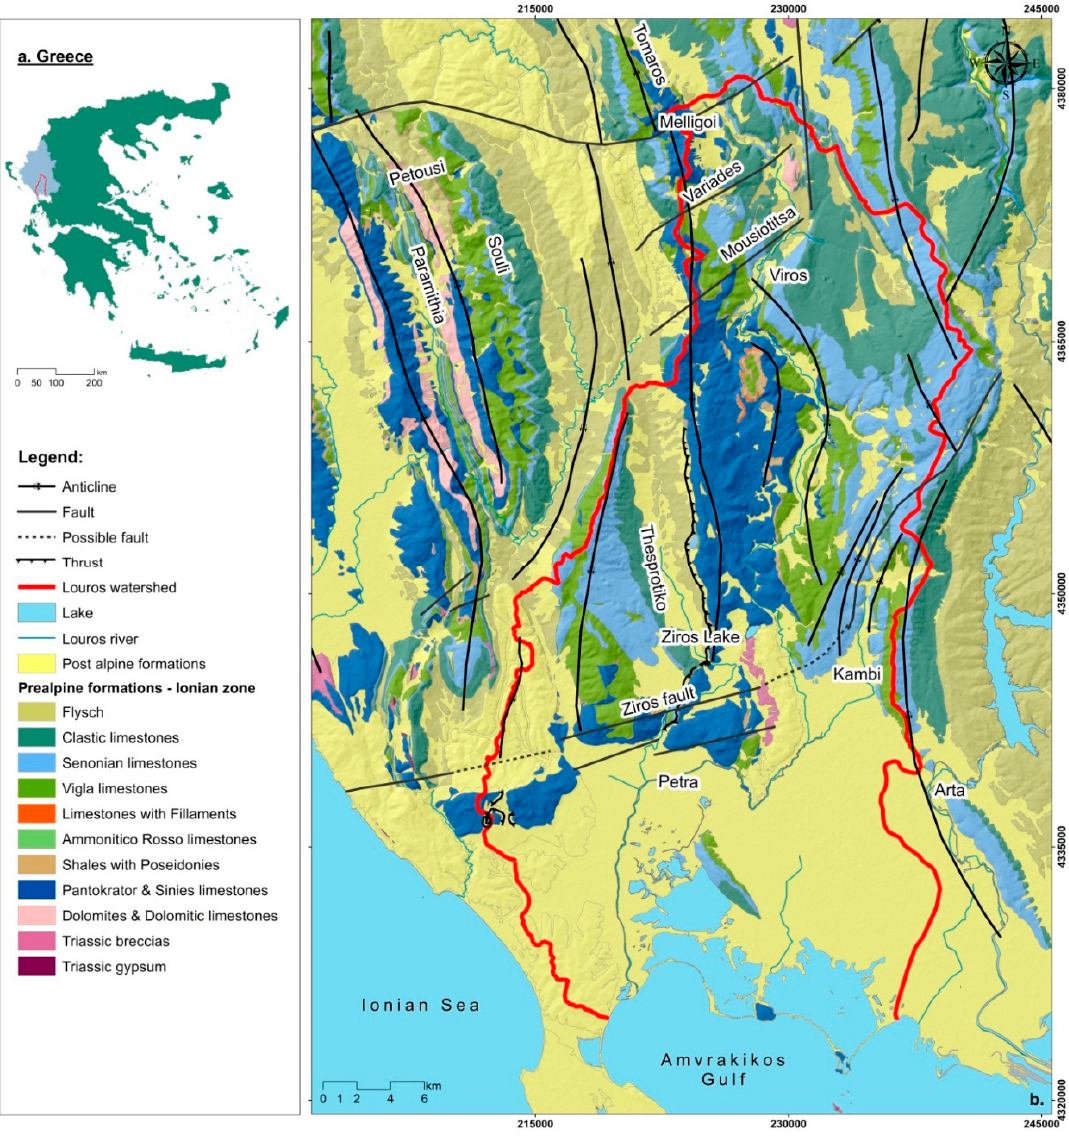
Figure 3. Geological map of the study area [44].